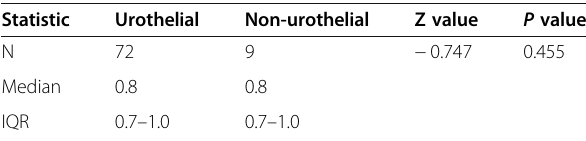
Table 7 Comparison of ADC values between urothelial and non-urothelial cell